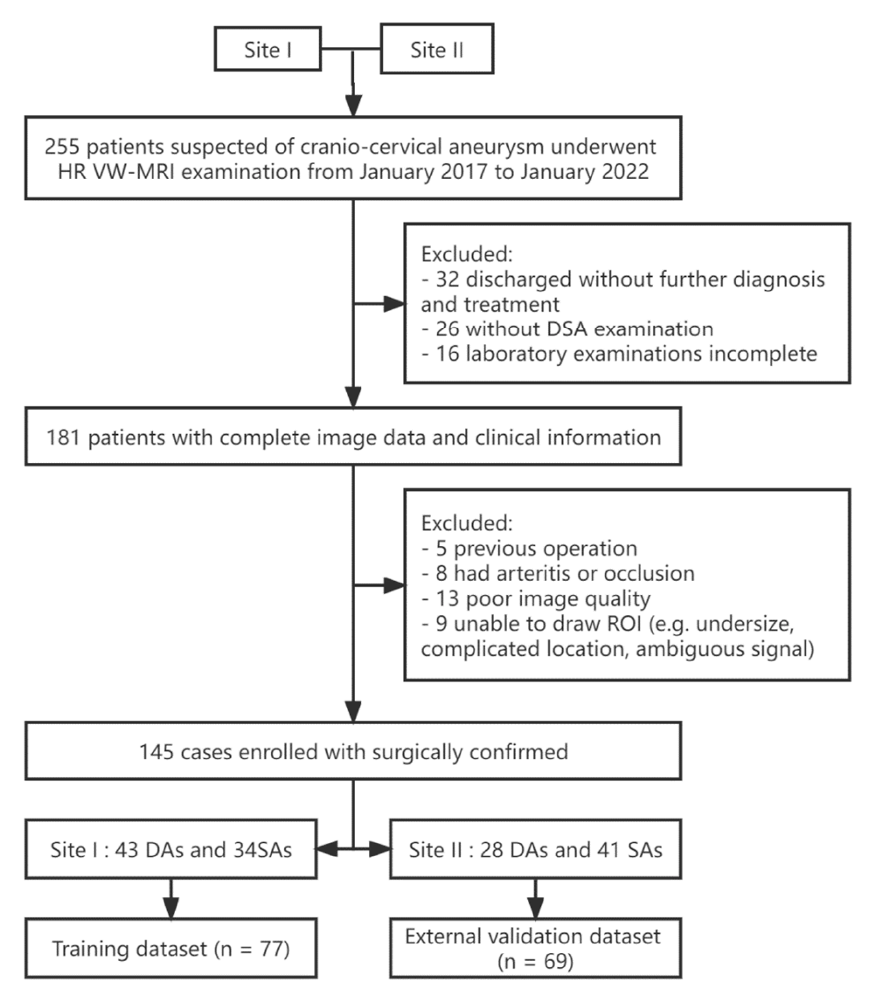
Figure 1. Flow chart of patient recruitment, inclusion, and exclusion criteria for the dataset.